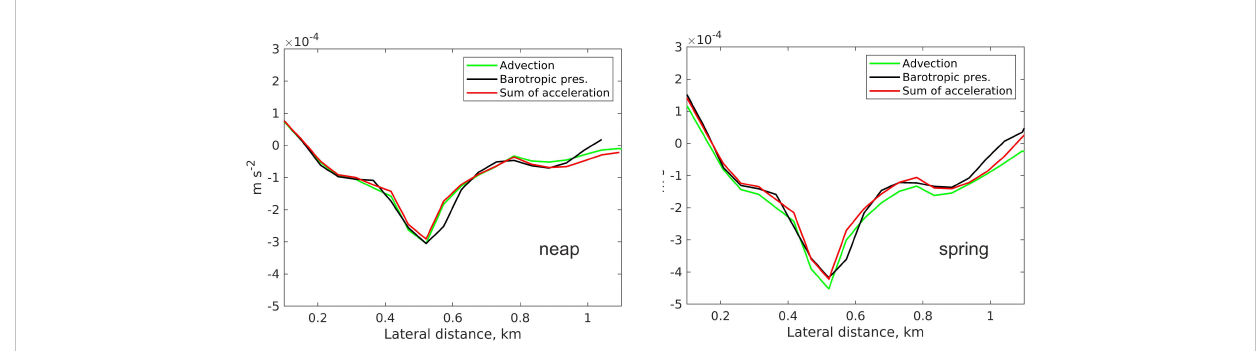
FIGURE 5 Vertical average of the forcing terms of the subtidal lateral momentum balance along the analyzed transect in (left) neap and (right) spring